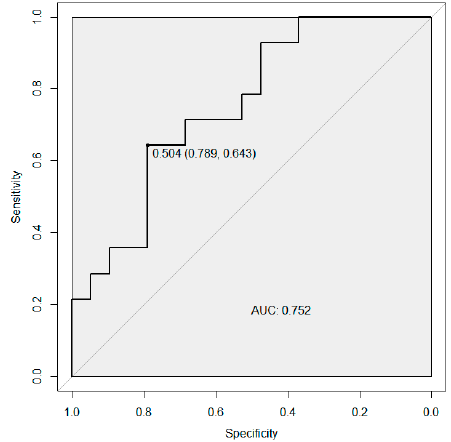
Figure 4. The ROC curve regarding the expression level of the miRNA-146a and miRNA-126 combination to discriminate irAEs grades after ICI therapy in ccRCC patients. ROC—receiver operating characteristic; AUC—area under the curve .